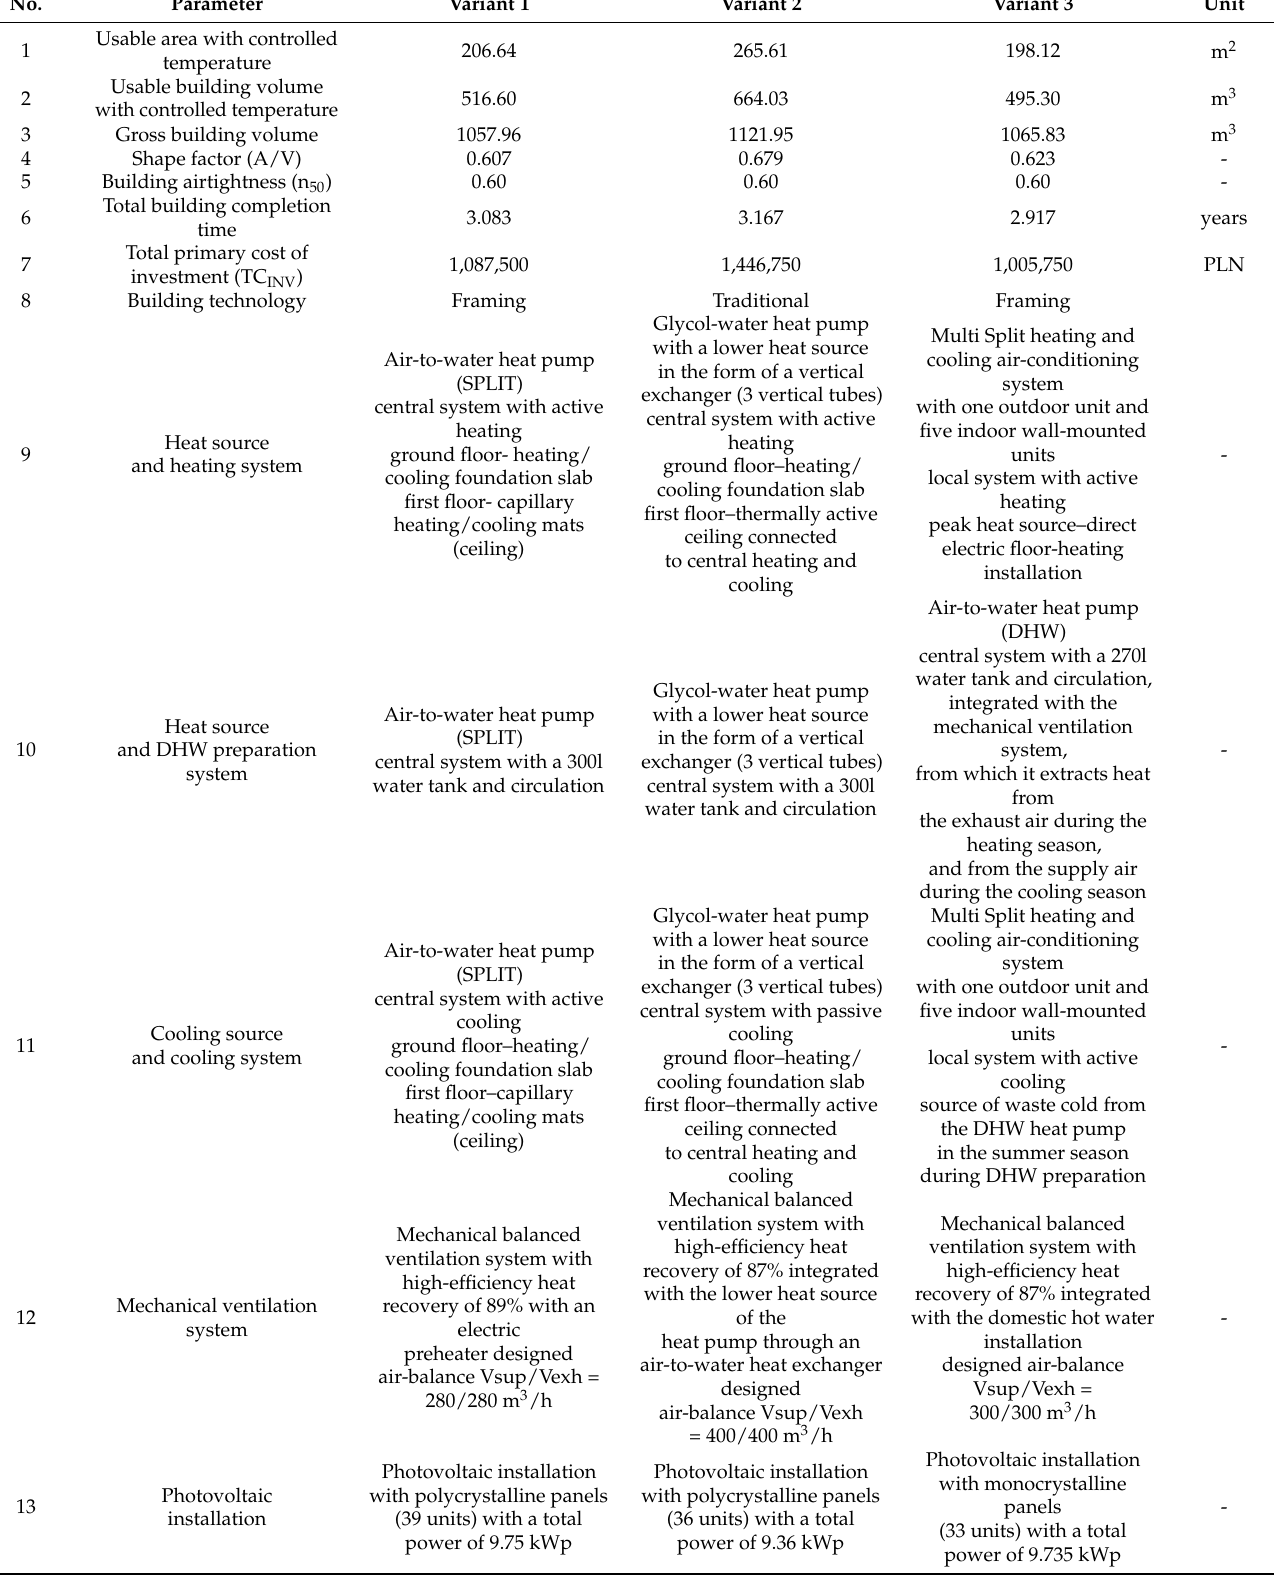
Table 1. Basic parameters for the variants of single-family residential buildings with positive energy